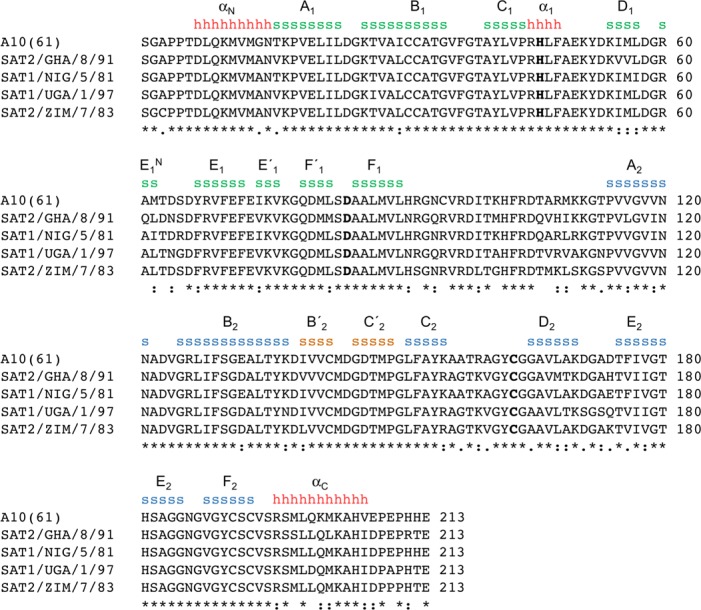
Amino acid sequence alignment of A1061 3Cpro with the 3C proteases from the four SAT serotypes used in this study.Secondary structure features are indicated (h = α-helix; s = β-strand), and coloured and labelled as in Fig. 2B (consistent with the naming scheme used in Birtley et al., 2005).